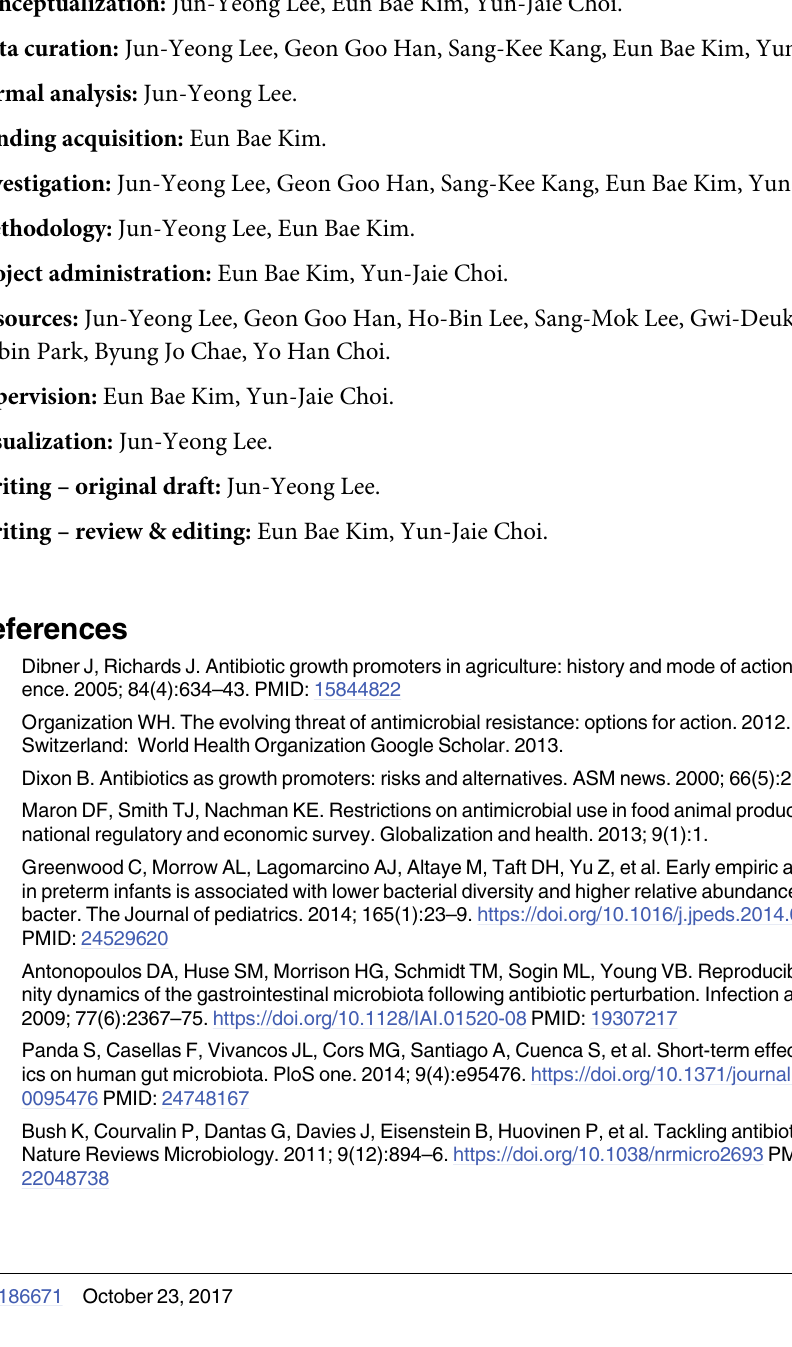
S2 Fig. Difference in cell aggregation of SBPs and SAPs. For this test, the L . salivarius strains were cultured for 24 h at 37˚C in shaking condition (240 rpm). Cell aggregation of the cultured bacteria was observed after incubation for 2 h at 37˚C in static condition. NC, negative control (MRS broth only). (TIF) S3 Fig. Competition assay with swine intestinal microbiota. Purified gDNA of L . salivarius KLF003 was used as the standard to calculate the cell numbers (see Materials and Methods).